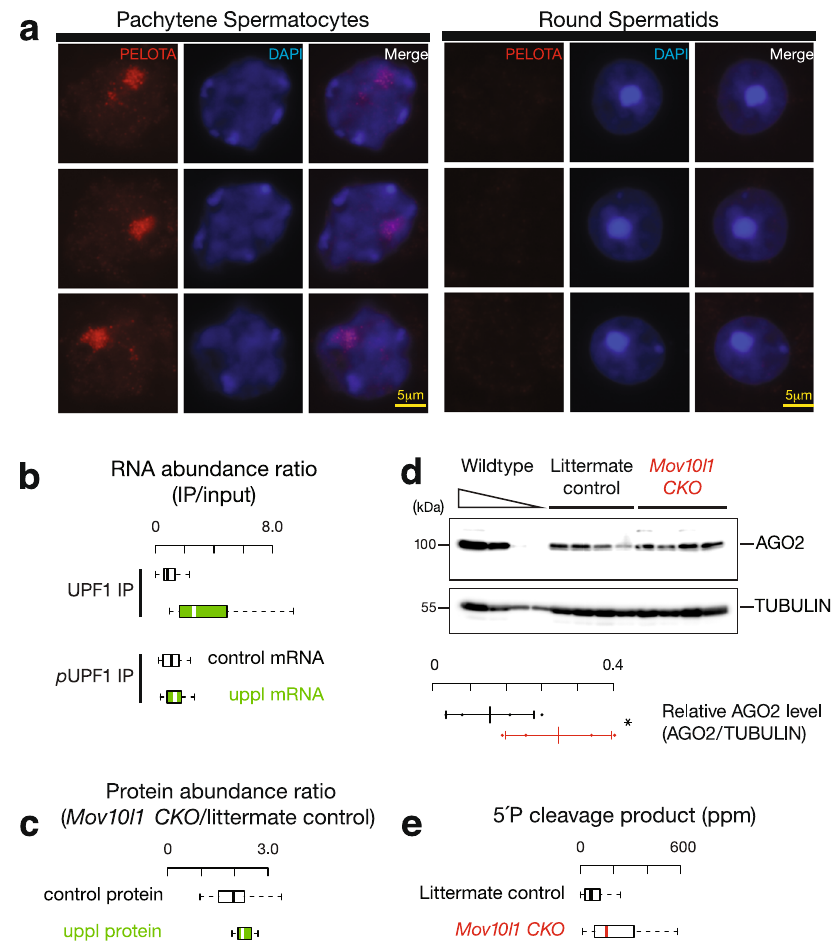
Fig. 5 3 ′ UTR piRNA biogenesis as a special co-translational mRNA decay pathway. a Immunolabeling of squashed pachytene spermatocytes (left) and round spermatids (right). Three examples of each stage were shown using anti-PELOTA, DAPI, and merged. Experiments were repeated at least three times independently with similar results. Scale bar, 5 μ m. b Boxplots of the ratios of RNA abundance in UPF1 IP (upper) and phosphorylated UPF1 IP mutant (lower) versus their corresponding input in adult wild-type testes. Control mRNA n = 43, uppl mRNA n = 30. c Boxplots of the changes of protein abundance coded per gene in Mov10l1 mutants (sample size n = 5 independent biological replicates) compared to littermate controls in adult testes. Control mRNA n = 43, uppl mRNA n = 30. d AGO2 western blot (top) and TUBULIN western blot (bottom) of adult testis lysates from serial dilutions of adult wild-type lysates (left) and four biological replicates of Mov10l1 CKO/ Δ Neurog3-cre (middle) and Mov10l1 CKO/ Δ (right). Abundance of AGO2 and TUBULIN was quanti fi ed using ImageJ 158 and then fi tted to the standard curve of the wild-type testis lysates. Relative abundance of AGO2 were calculated as the abundance of AGO2 normalized by the abundance of TUBULIN (sample size n = 4 independent biological samples). Data are mean ± standard deviation; * p = 0.048, one-side Student ’ s t test. Each data point was overlaid as dot plots. e Boxplots of the 5 ′ P decay intermediates per mRNA in adult wild-type testes. AGO2 target transcripts n = 41. Box plots in ( b , c , e ) show the 25th and 75th percentiles, whiskers represent the 5th and 95th percentiles, and midlines show median